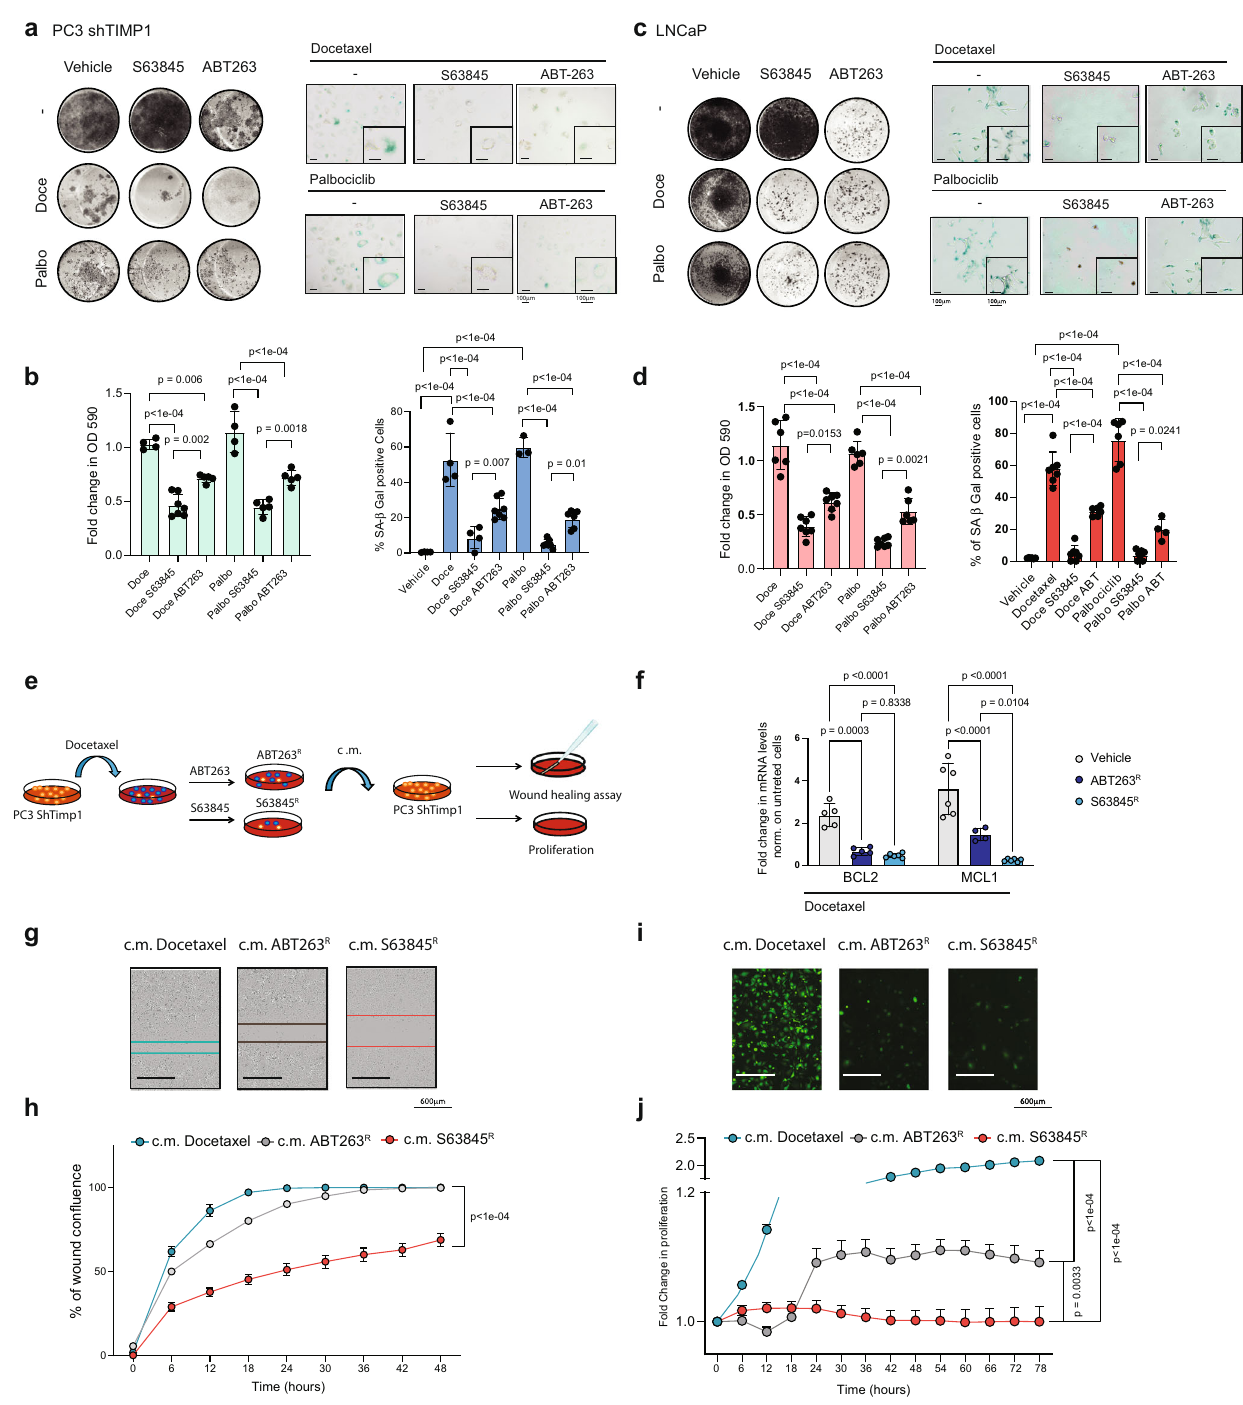
mouse cross-reactivity using biotinylated Anti-Mouse antibody (Vector Labora- tories, Cat No. BP-9200). Sections were stained with respective primary